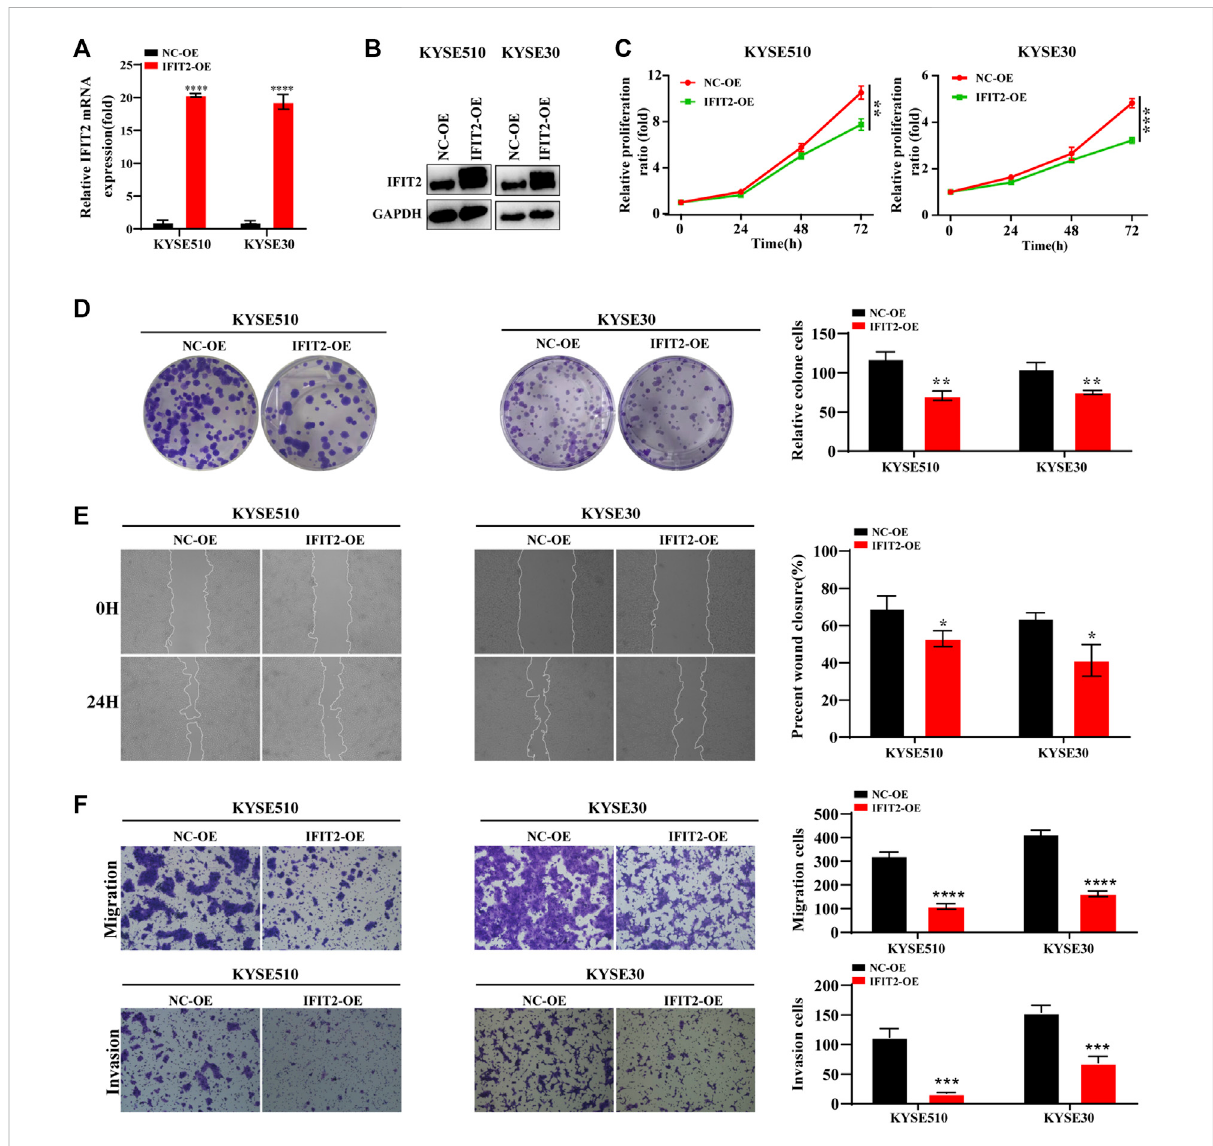
FIGURE 5 IFIT2 overexpression inhibited ESCC cell proliferation and invasion (A, B) . To evaluate the effectiveness of the IFIT2 overexpression lentivirus, qRT ‒ PCRwasusedtodetectmRNAlevels,andwesternblotanalyseswereusedtodetectproteinlevels. (C) .ACCK-8assaywasusedtoevaluatethe proliferation ability of KYSE510 and KYSE30 cells after IFIT2 overexpression. (D) . Cell proliferation capabilities were identi fi ed through colony formation tests intransfected KYSE510 and KYSE30 cells. (E) . The wound healing assay reduced the KYSE510 and KYSE30cell ability to migrate. (F) . Transwell assays were used to analyze transfected cell migration and invasion. * p < 0.05, ** p < 0.01, *** p < 0.001, **** p <